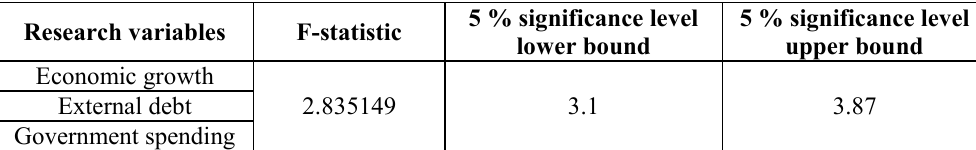
Table 7. Bound Cointegration Test